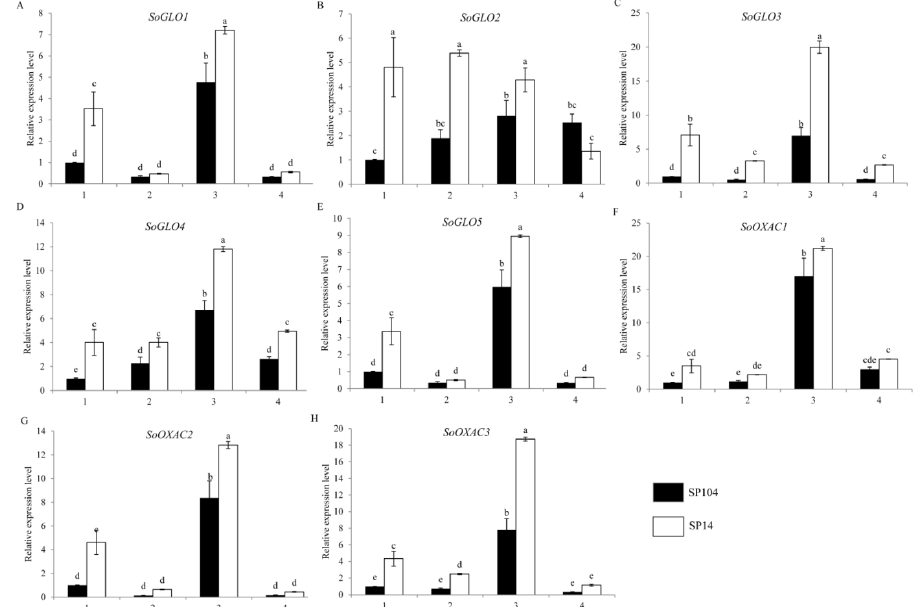
Figure 4. Expression profiles of putative genes involved in oxalate biosynthesis pathways in spinach. The four parts were as follows: (1) mature leaf laminas; (2) mature leaf petioles; (3) young leaf laminas; and (4) young leaf petioles. Error bars represent standard deviation among three real-time quantitative PCR reaction replicates. Data are means of three replicates ± SD. Different lowercase letters indicate significant differences at P <